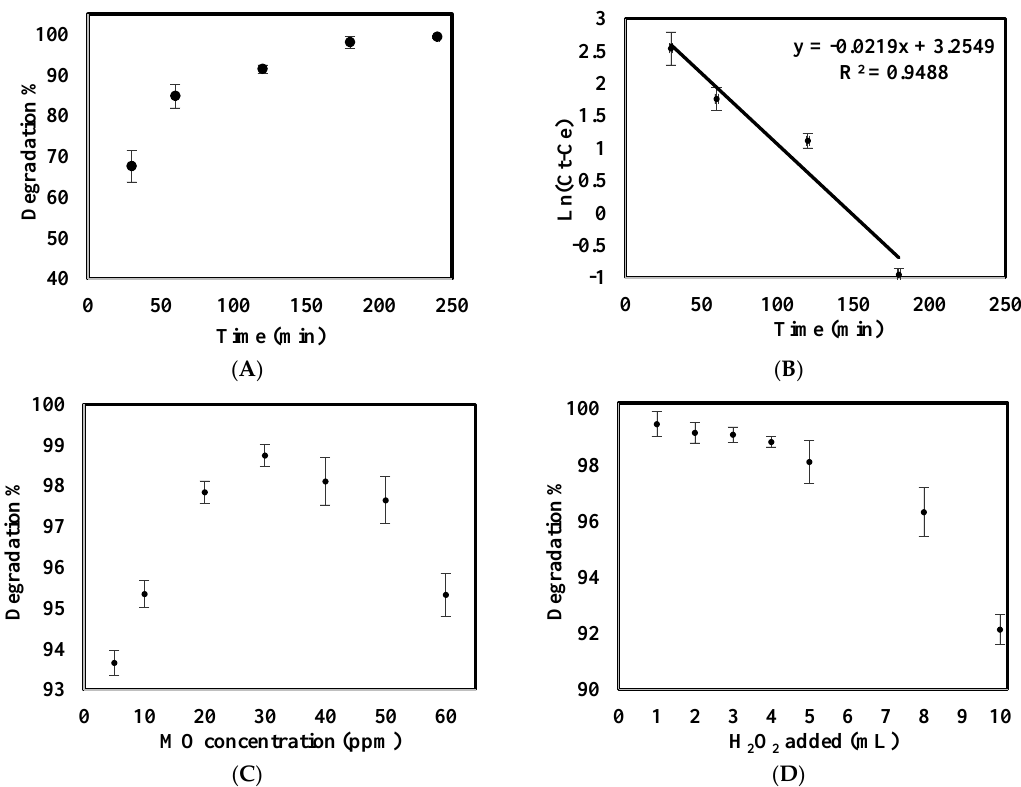
Figure 6. ( A )The degradation of MO as a function of time; ( B ) Pseudo first-order kinetic model of the degradation reaction; ( C ) The degradation of MO as a function of initial MO concentration; and ( D ) The degradation of MO as a function of a volume of H 2 O 2